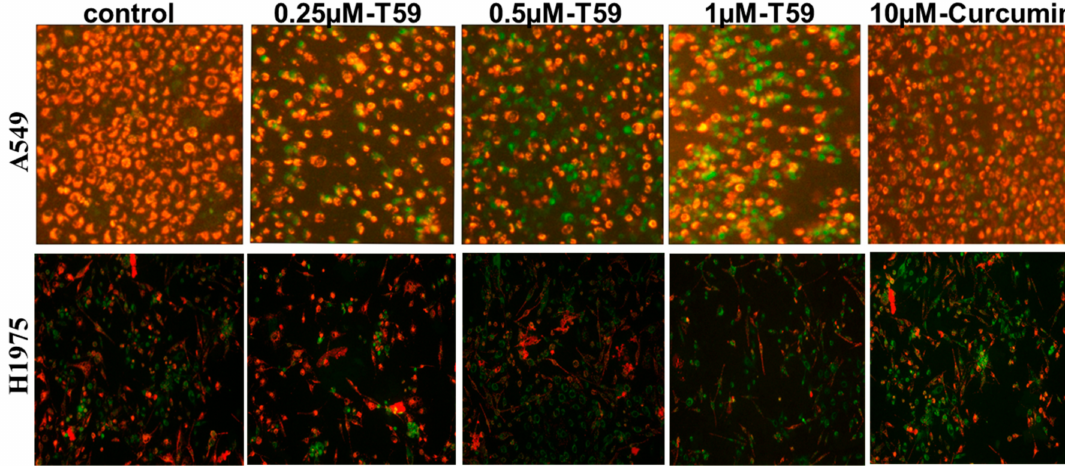
Figure 3. The effect of T59 on A549 cell membrane potential. A549 and H1975 cells were treated with 0.250 μ M, 0.500 μ M, and 1.000 μ M T59 and with 10.000 μ M curcumin for 24 h. Fluorescent micrographs (×100) of JC-1 stained.